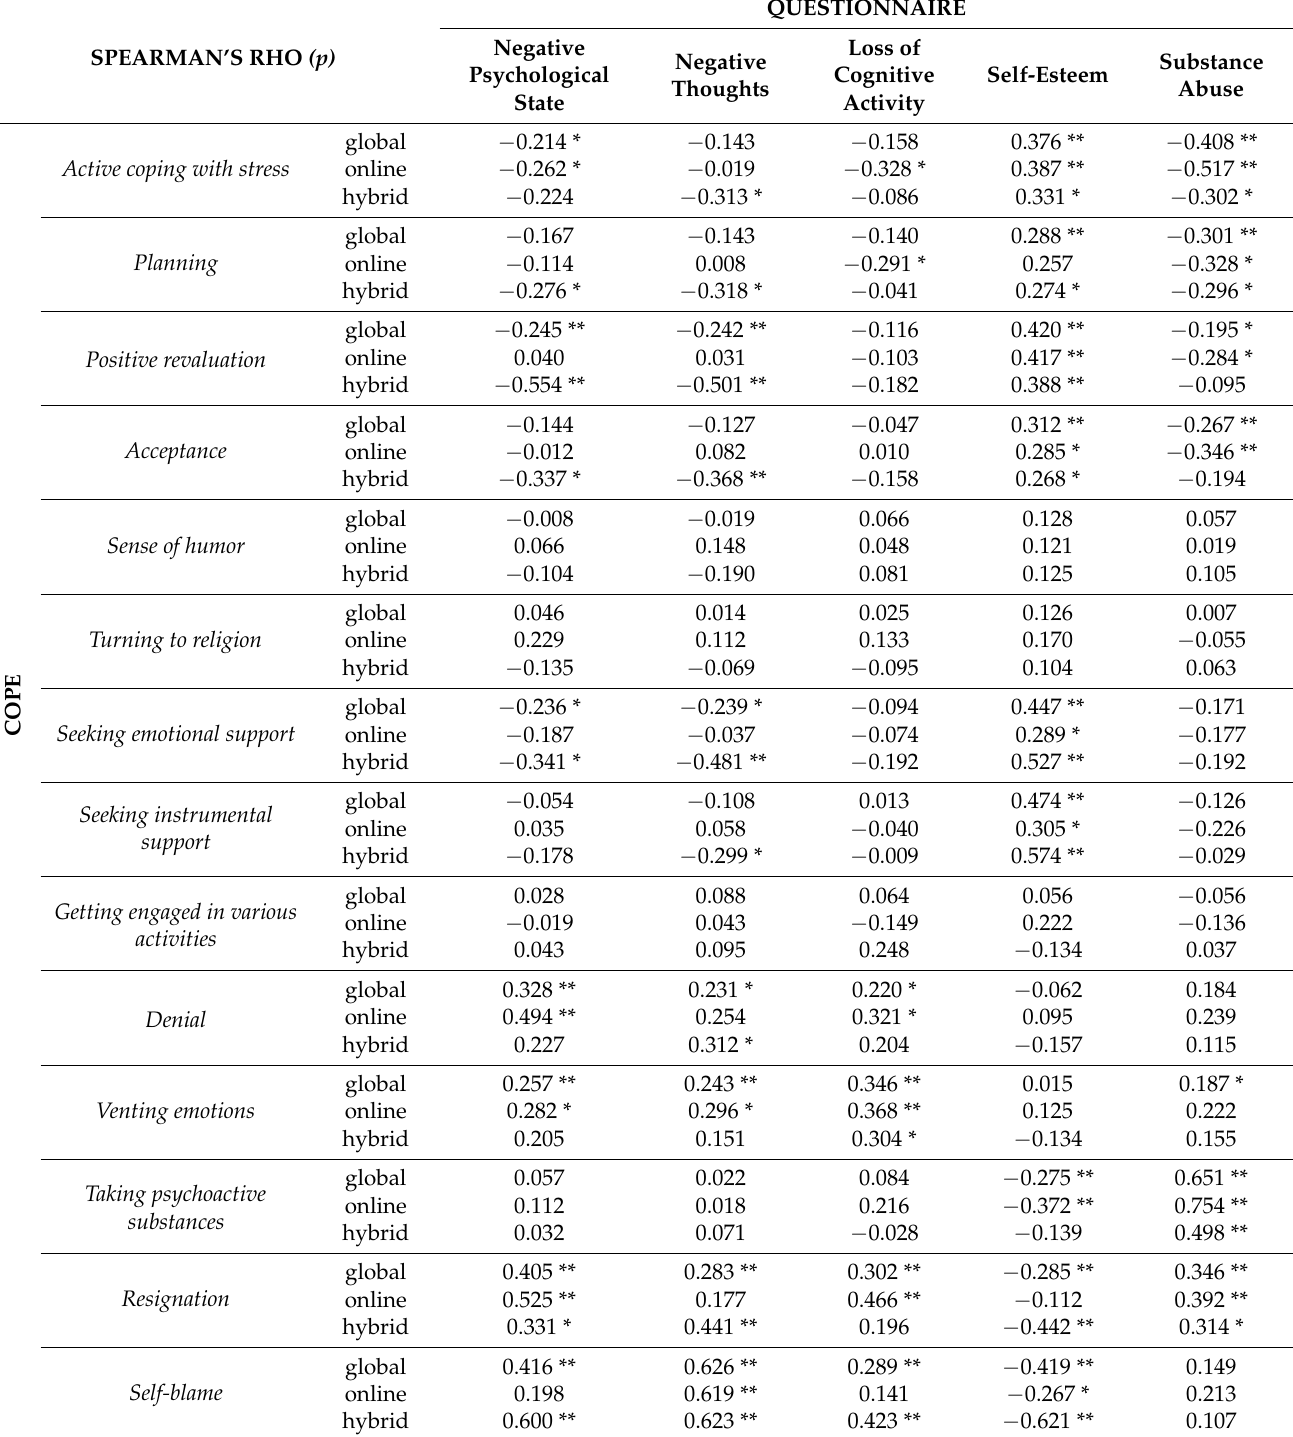
Table 3. Correlations between non-clinical symptoms of a low mood or depression and coping strategies in difficult and stressful situations for general ( n = 114) and online (n = 58) and hybrid learning group (n =